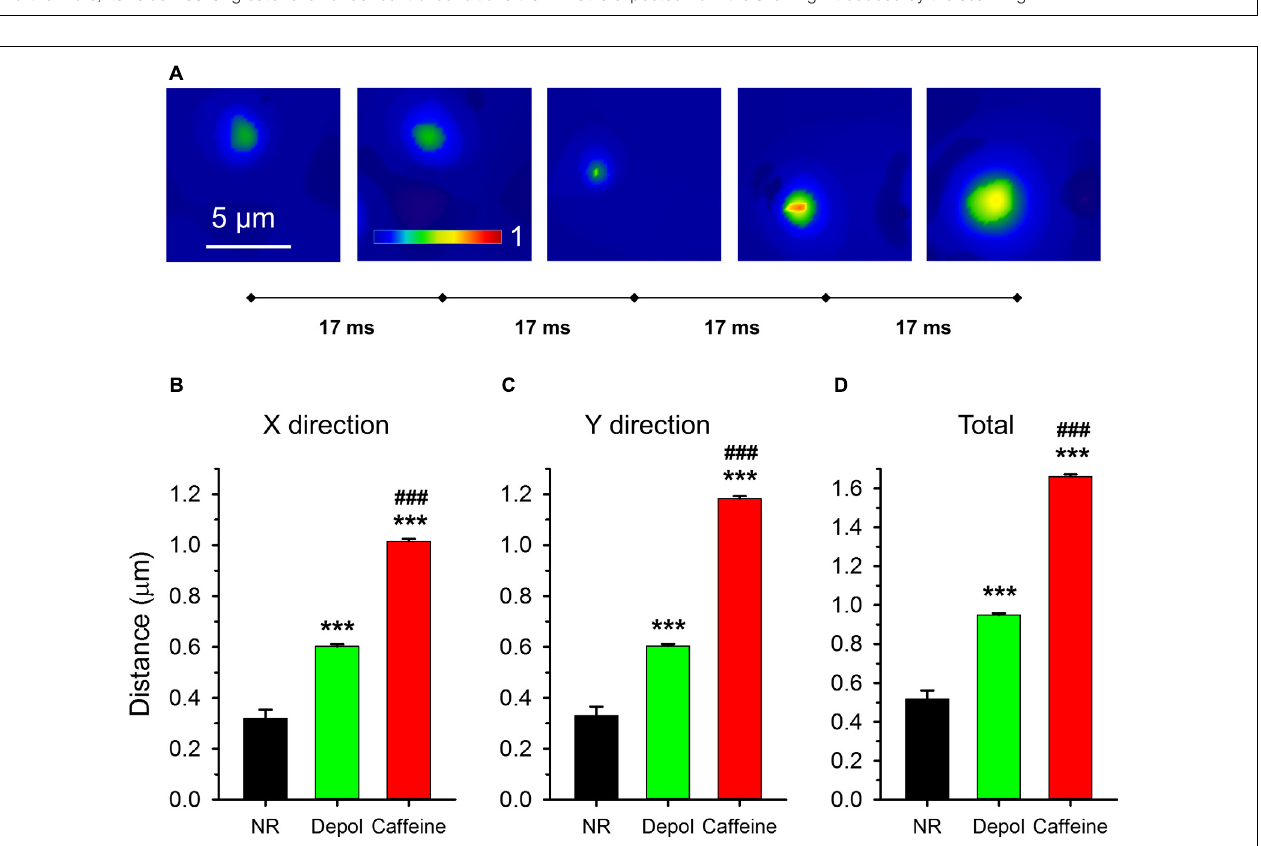
FIGURE 8 | Modified eccentricity of the sparks (A) . Distribution of the modified eccentricity calculated using Eqn. 2 for control conditions (NR, black circles), for depolarized fibers (green squares), and in the presence of caffeine (red triangles). Note that albeit negative values were present, the distribution is not symmetric, it is shifted toward positive values indicating that FWHM-X was, in most cases, greater than FWHM-Y. (B) Average modified eccentricity for the three experimental conditions calculated using only the positive values from panel (A) . Note that both the depolarization and caffeine treatment increased the modified eccentricity, and, furthermore, its value was far greater even under control conditions than what is expected from the skewing introduced by the scanning.